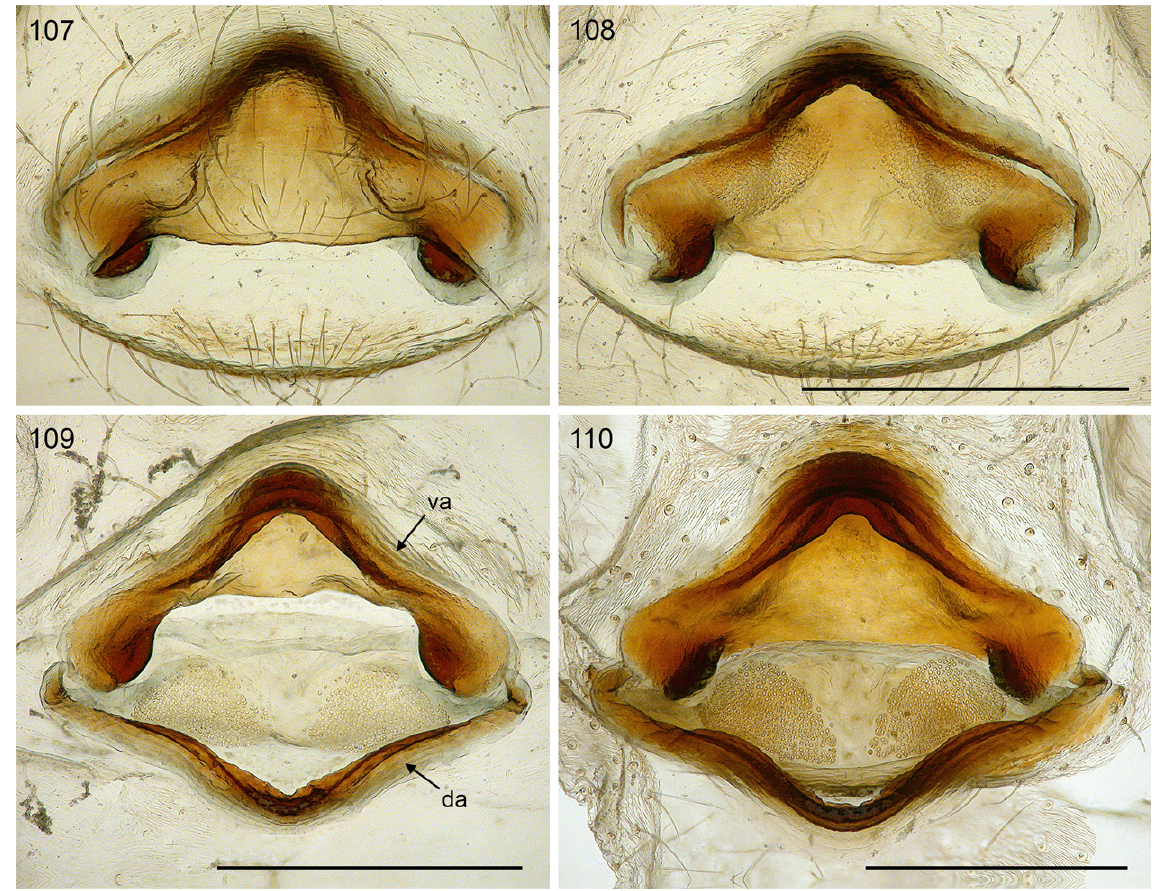
Figs 107–110. Holocnemus caudatus (Dufour, 1820). 107–109 . Female from Spain, Valencia, Montroy (MHNG); internal genitalia, ventral view, regular dorsal view, and dorsal view with dorsal arc tilted backwards. 110 . Female from Spain, Albacete, S of Tarazona de La Mancha (CRB); internal genitalia, dorsal view with dorsal arc tilted backwards. Abbreviations: da = dorsal arc; va = ventral arc. Scale bars = 0.5